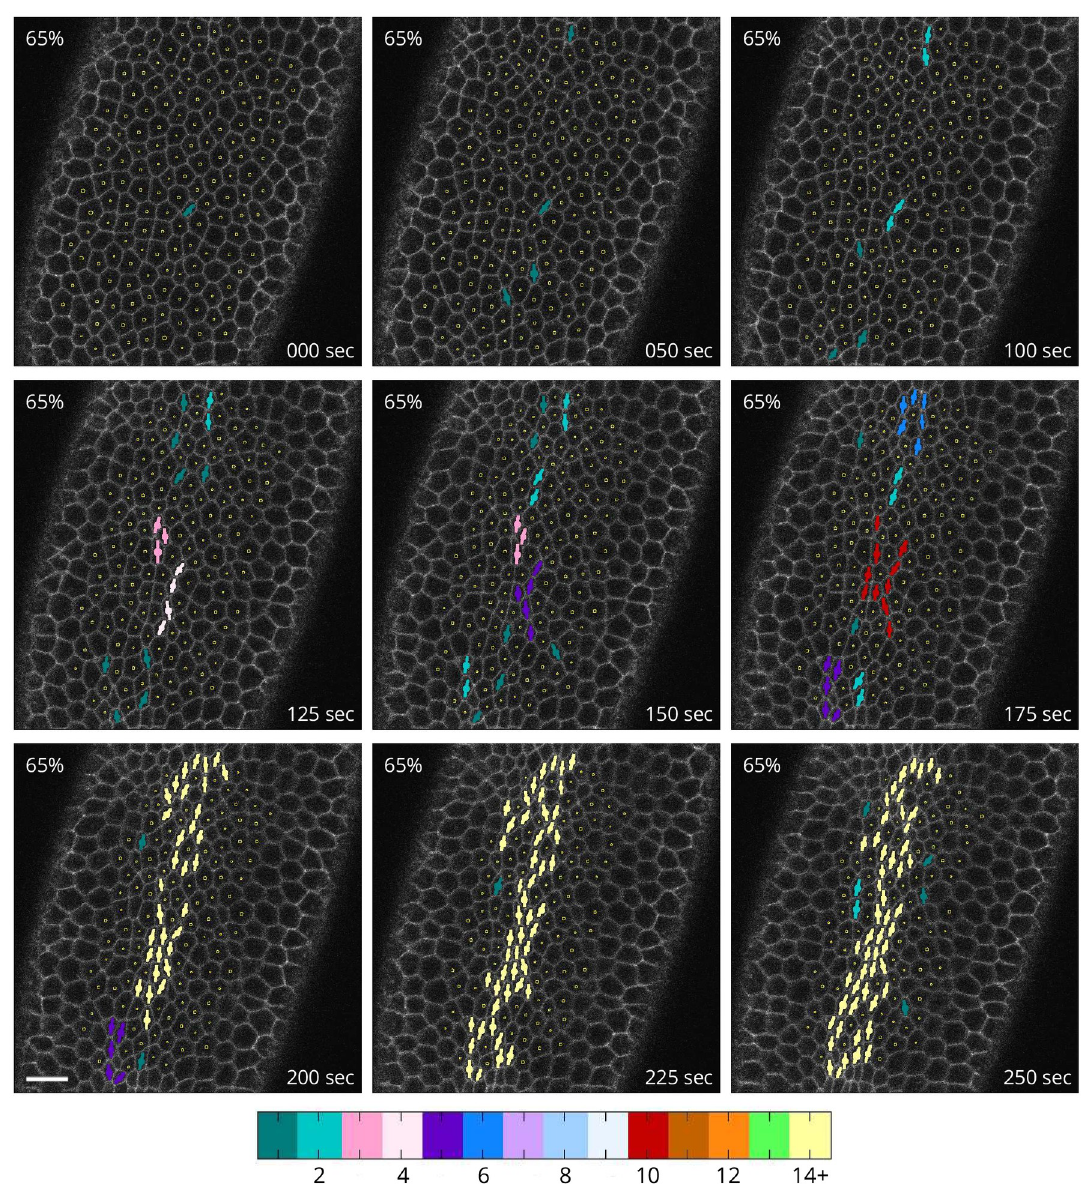
Fig 2. Development of constriction chains during the slow apical constriction phase of VFF. Time lapse images of the underside of a Spider-GFP embryo showing constricted apices defined by the minor-axis reduction threshold r c = 0.65. Symbols per Fig 1. Color bar indicates the number of cells in the constricted-cell cluster interconnected via shared neighbors. Constricted cells initially form a sparse pattern, extending in the anteroposterior direction. Subsequently, cells rapidly interconnect into elongated chains of constricted cells, forming a constricted-cell network that percolates across the mesoderm primordium along the anteroposterior axis. Many of the marked cells remain constricted across multiple frames, indicating that they are undergoing ratcheted constrictions [24]. Unratcheted constrictions can also be seen. Time point zero was determined by the first observed apical constriction. Scale bar: 10 μ m.